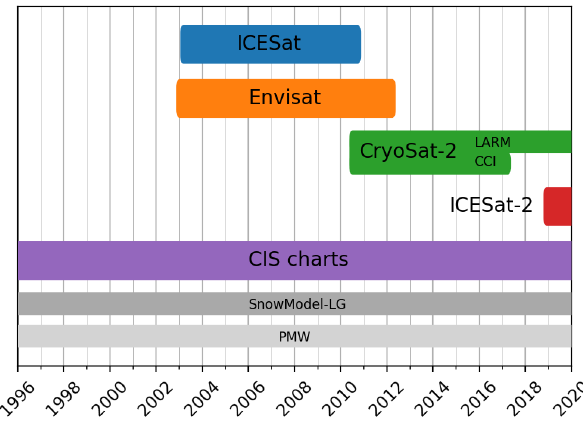
Figure 2. Timeline of different datasets used in this